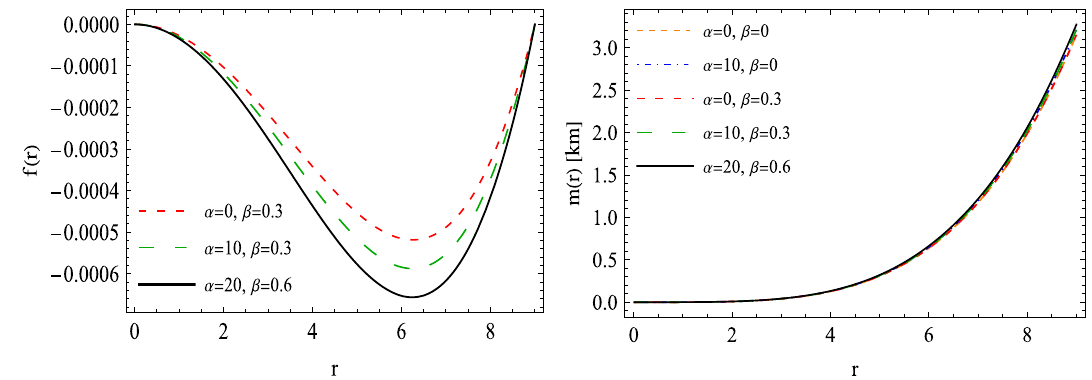
Fig. 5 The behavior of deformation function f ( r ) - left panel and mass function m ( r ) - right panel versus r for solution Sect. 3.2